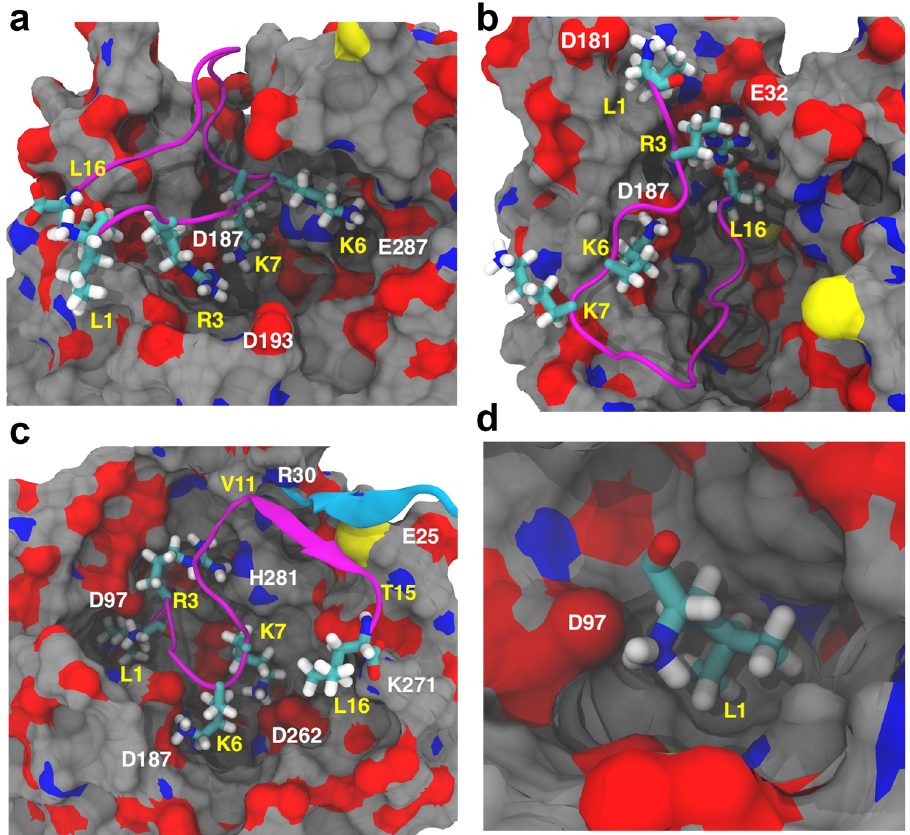
Fig. 3 Analysis of the interactions between CXCR4 and EPI-X4 in the MD simulations. Binding modes MID-IN1 ( a ), CTER-IN ( b ), and NTER-IN ( c , d ) were identi fi ed from the clustering analysis. CXCR4 is represented as surface (carbon = gray, oxygen = red, and nitrogen = blue) and EPI-X4 is shown in cartoon diagram (purple). Important residues of EPI-X4 are shown as sticks and labeled in yellow. CXCR4 residues involved in the binding are labeled in white. The β -strand of CXCR4 comprising residues E25 – R30 is shown in